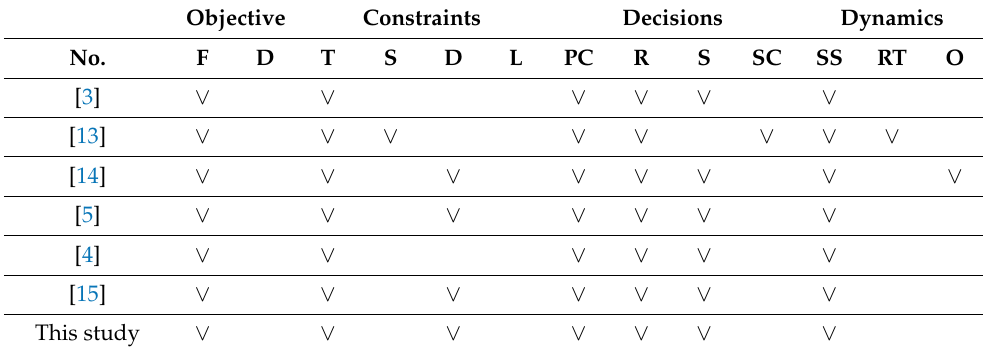
Table 1. Comparison of our study to previous VRPP